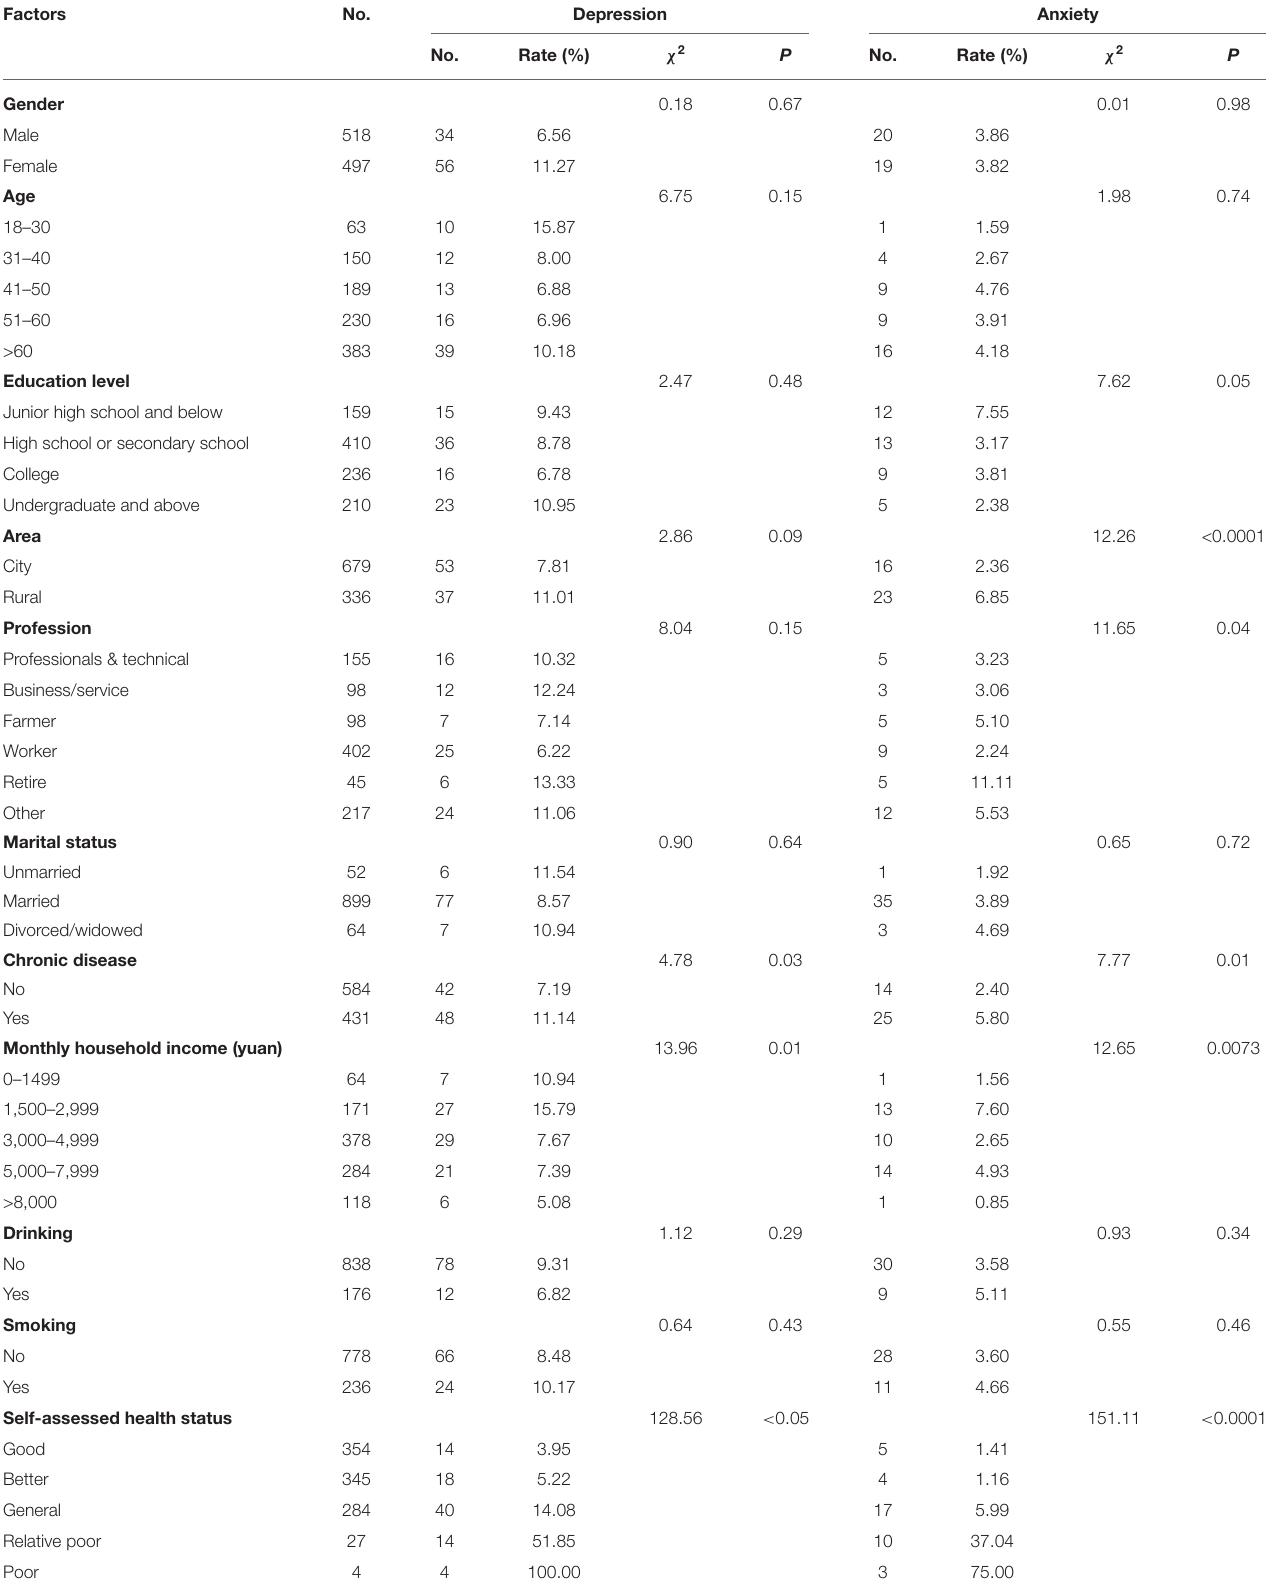
TABLE 2 | The mental health status of